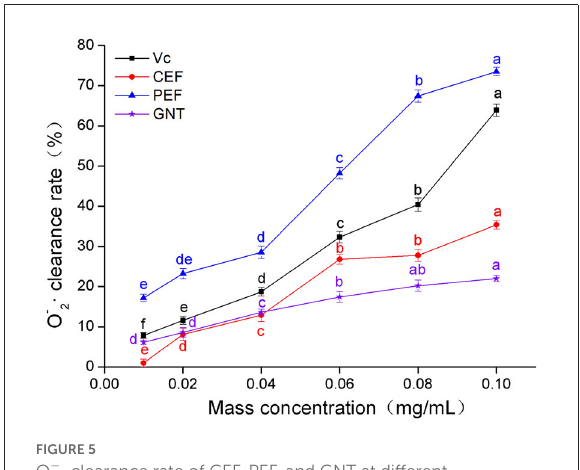
FIGURE5 O − 2 · clearance rate of CEF, PEF, and GNT at different concentrations. Different letters indicate significant differences in O − 2 · scavenging ability of the same substance at different concentrations ( p <